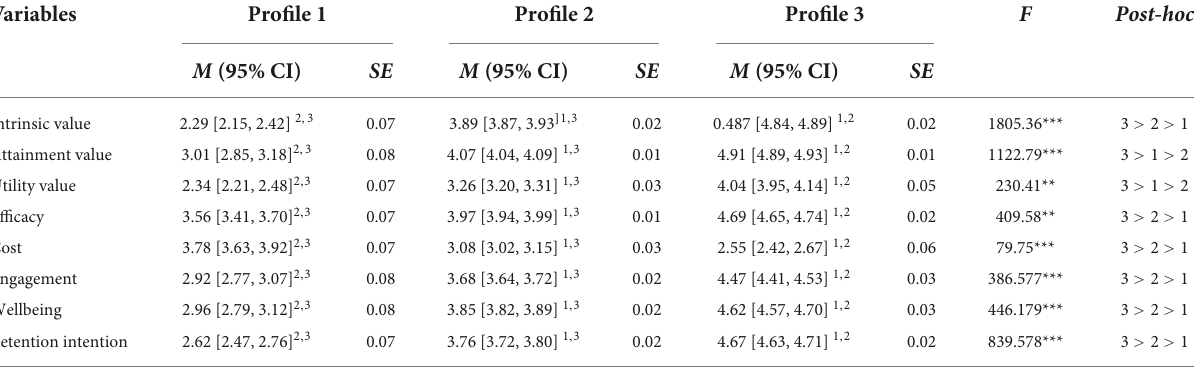
TABLE 4 Adjusted standardized means and standard errors of the three motivation